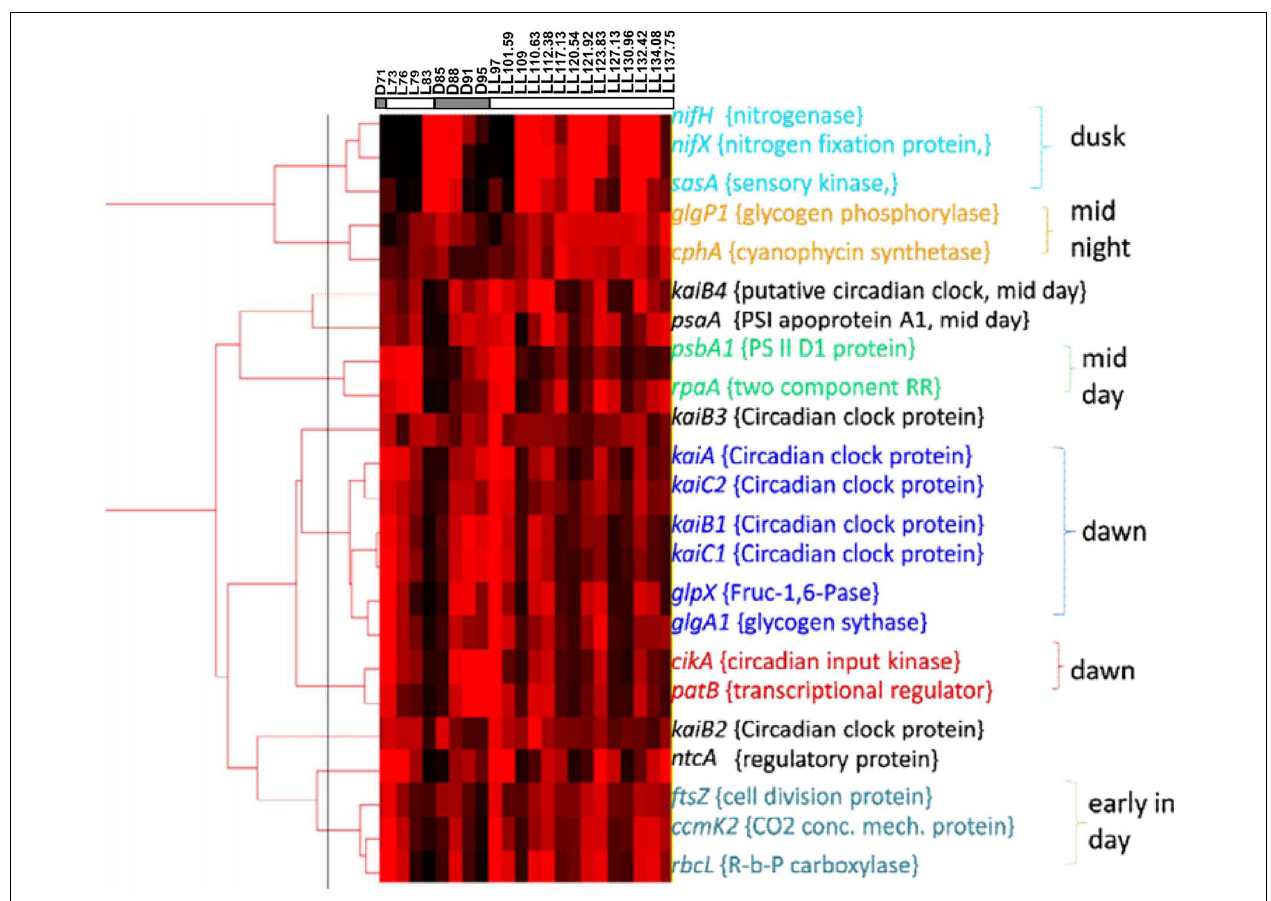
FIGURE 4 | Clustering analysis on basis of the Real time PCR expression data of genes coding for clock genes, input and output pathway of circadian rhythm and selected representatives from genes involved in various metabolic